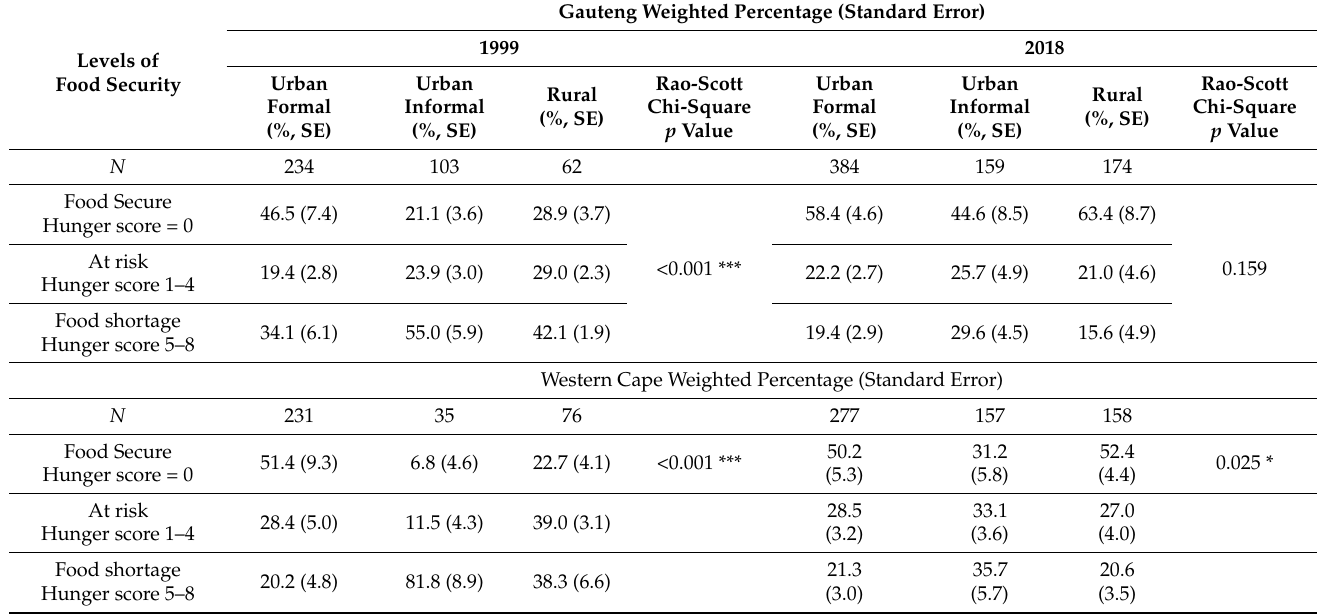
Table 4. Comparison of households falling within different hunger scale categories $ by domain of residence within Gauteng and the Western Cape.